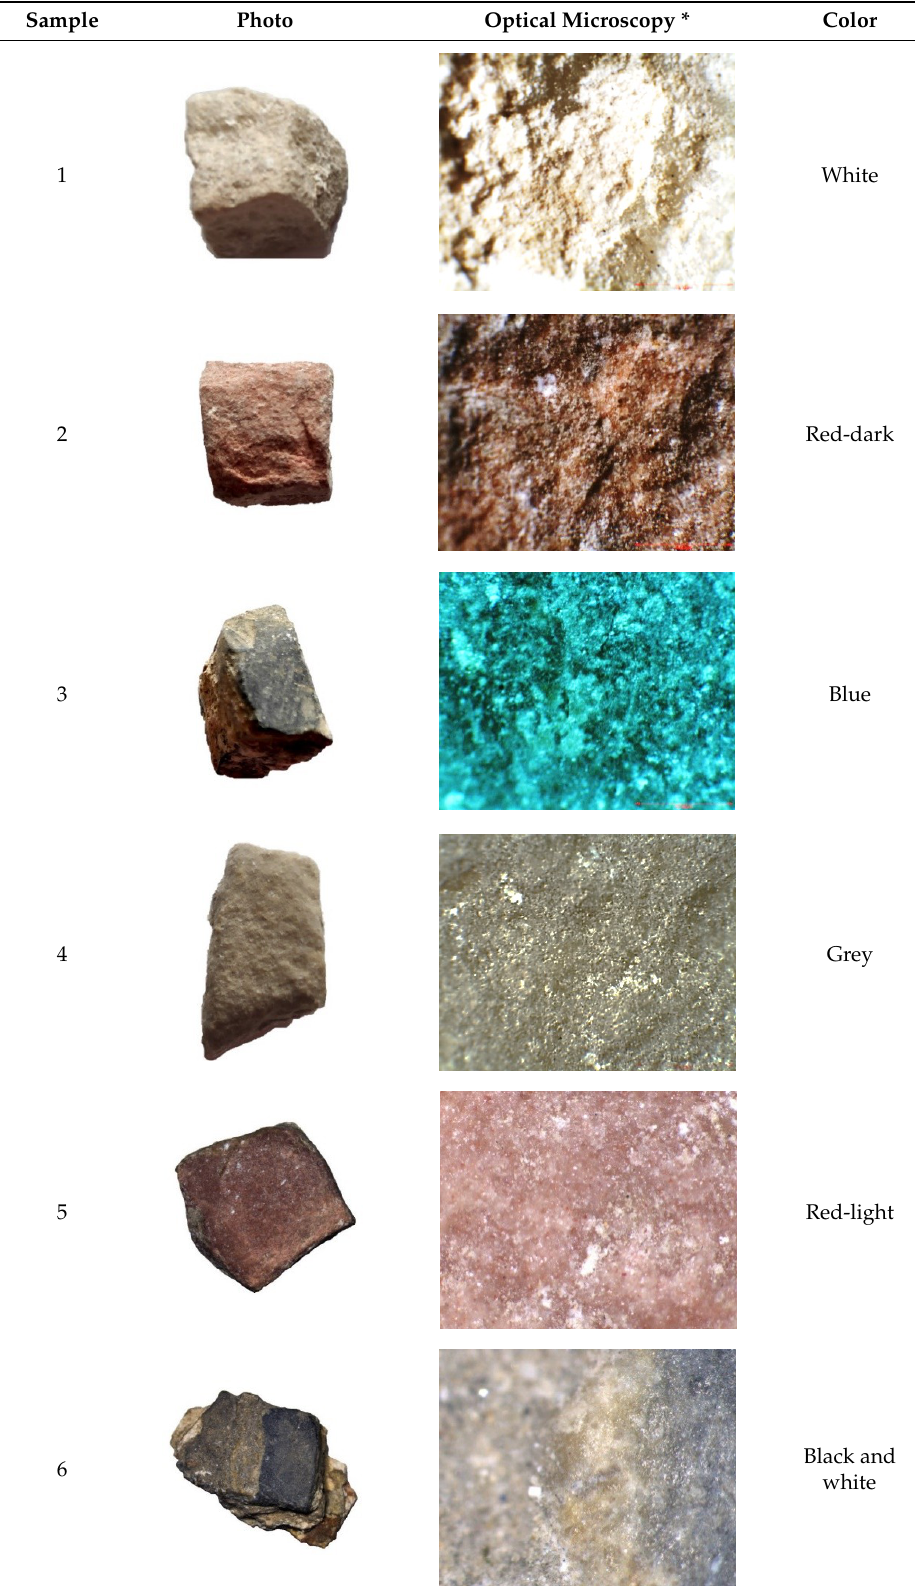
Table 1. The sample labeling: photos, optical microscopy images, and color of the studied mosaic fragments. Sample